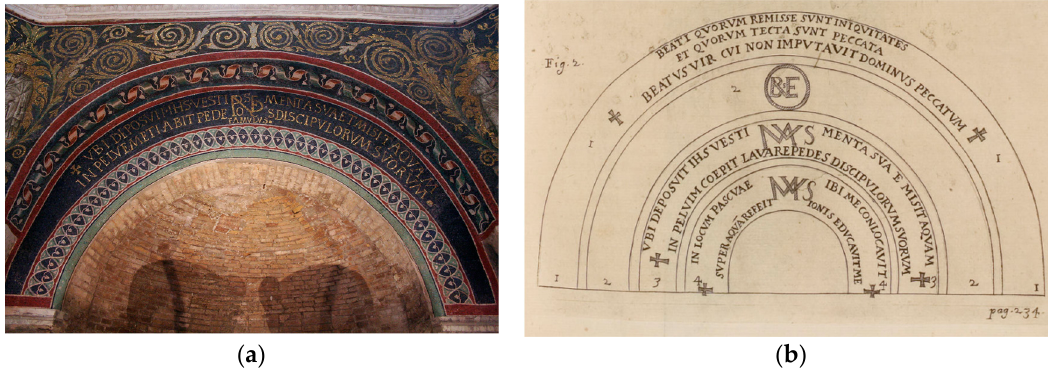
Figure 3. Monograms on the arches of the Baptistery of the Cathedral, Ravenna: ( a ) northeastern arch and niche (photo author); ( b ) drawing of extant monograms in 1690 (after Ciampini 1690, t.